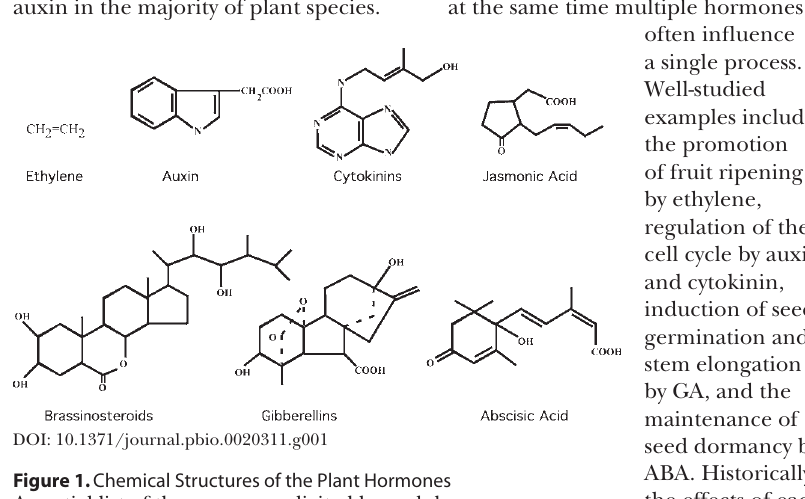
Figure 1. Chemical Structures of the Plant Hormones A partial list of the responses elicited by each hormone is provided below. Ethylene gas promotes fruit ripening, senescence, and responses to pathogens and abiotic stresses. IAA (an auxin) regulates cell division and expansion, vascular differentiation, lateral root development, and apical dominance. Cytokinins are adenine derivatives fi rst identifi ed by their ability to promote cytokinesis. JA is a volatile signal that modulates pollen development and responses to pathogen infection. The BRs regulate cell expansion and photomorphogenesis (light- regulated development). GAs are diterpenoid compounds that promote germination, stem elongation, and the induction